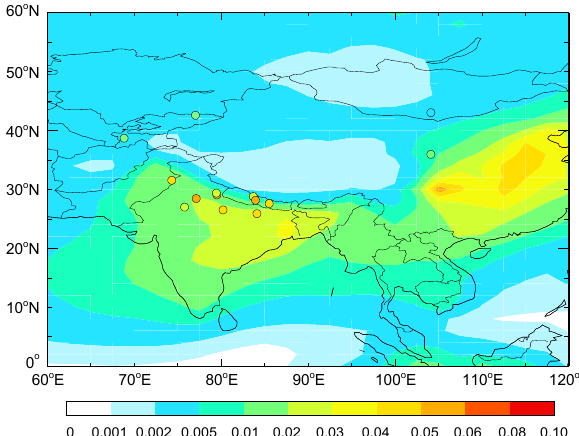
Figure 8. GEOS-Chem simulated annual mean BC AAOD (color contours) for 2006. Colored circles are values retrieved from AERONET observations (see Table